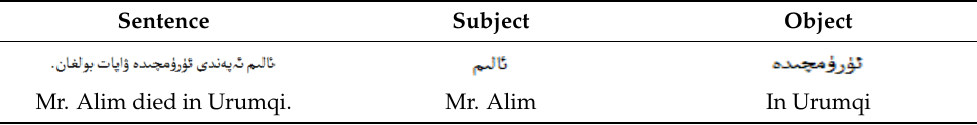
Table 1. Task examples of triplet extraction.